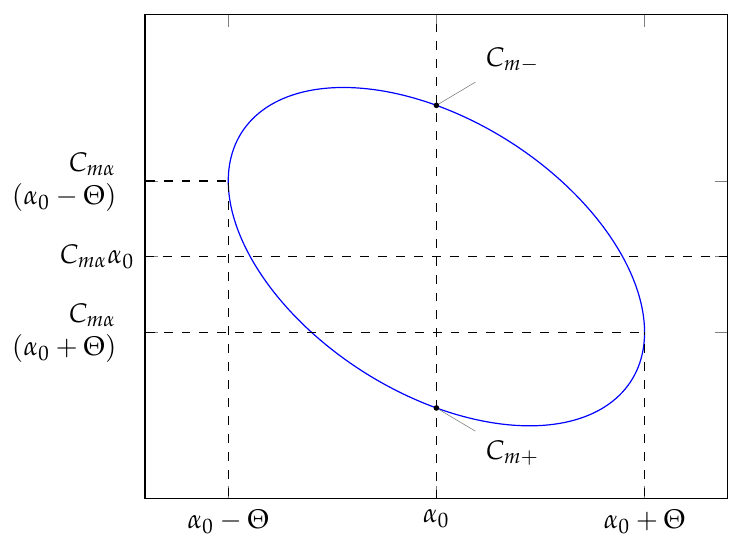
Figure 8. Typical shape of C m ( t ) over α ( t )